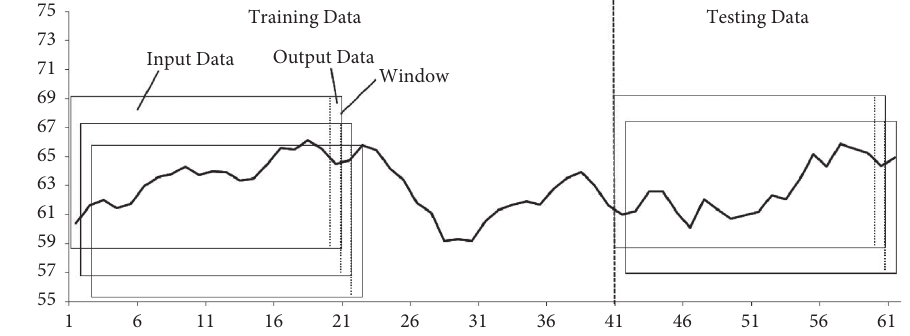
Figure 9: Sampling process of the moving window.